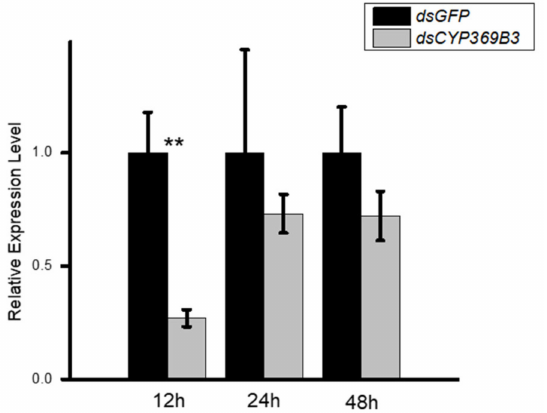
Figure 4. The analysis of the expression of CYP369B3 after RNAi. Differences in the expression levels of each target were compared using a t -test. Significant differences are indicated by asterisks (** p < 0.01).